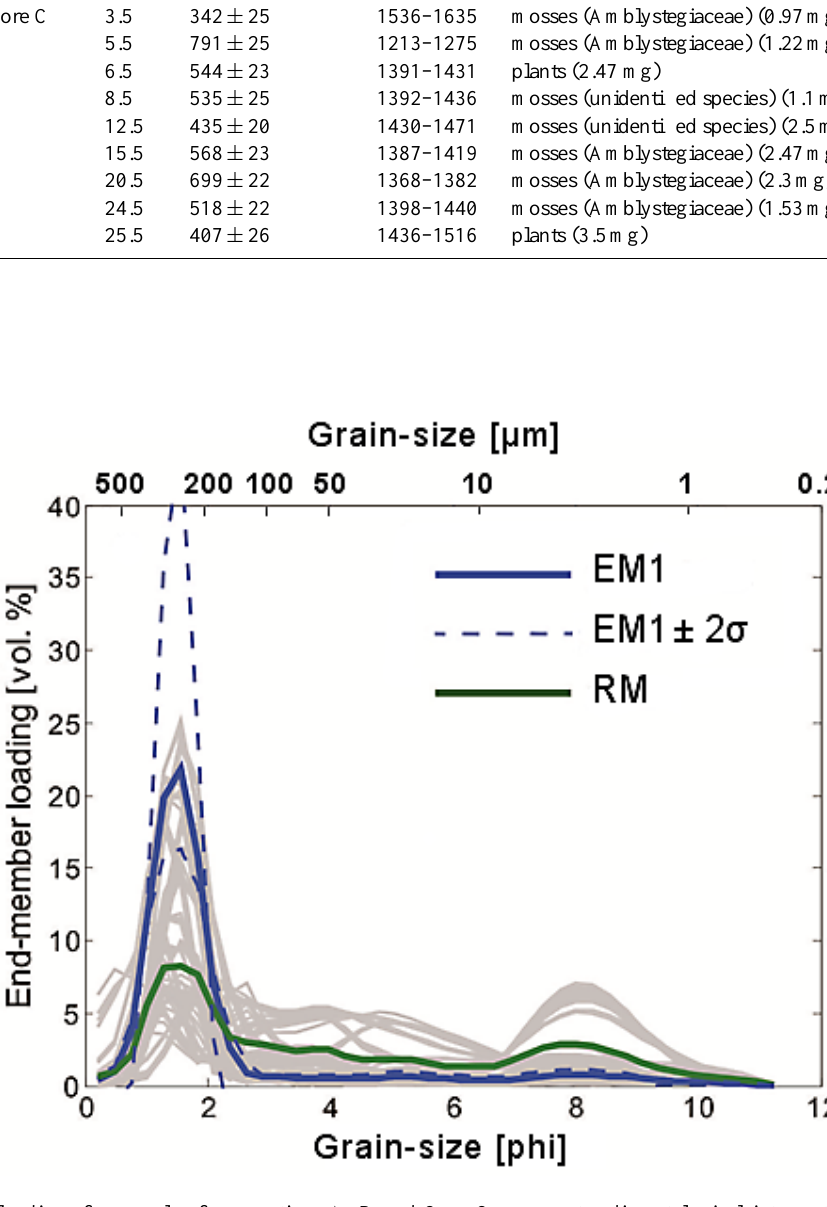
Fig. A1. Endmember loadings for samples from sections A, B and Core C represent sedimentological interpretable unmixed grain-size distributions (grey solid lines: all endmembers from the 16 endmember modelling